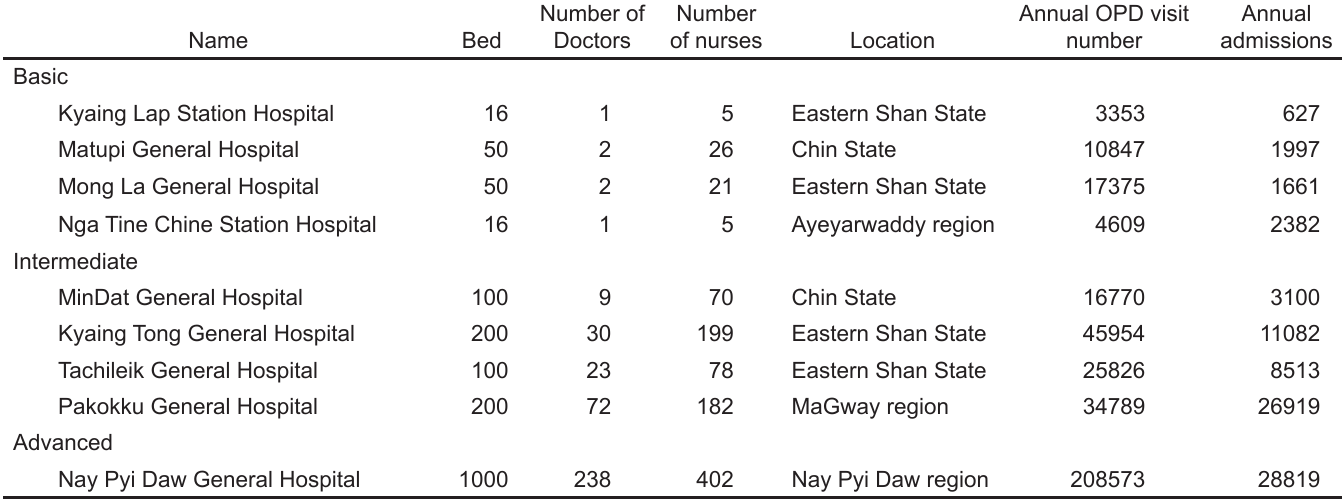
Table 1. Overview of hospitals included in a survey of emergency medical care delivery in Myanmar.